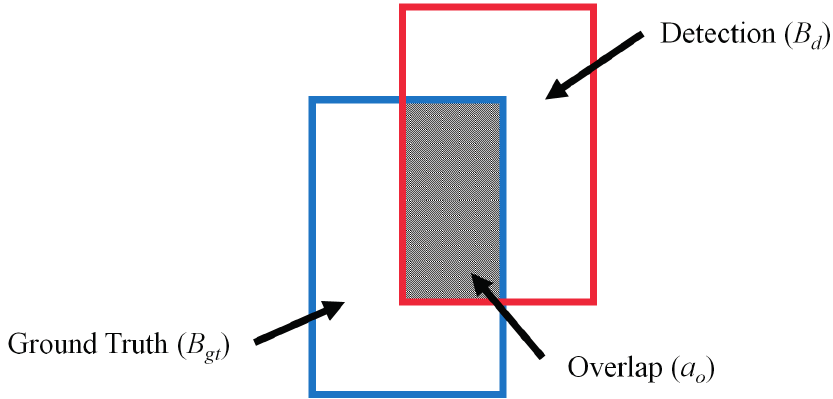
Figure 14. Overlapping area of ground truth and detected